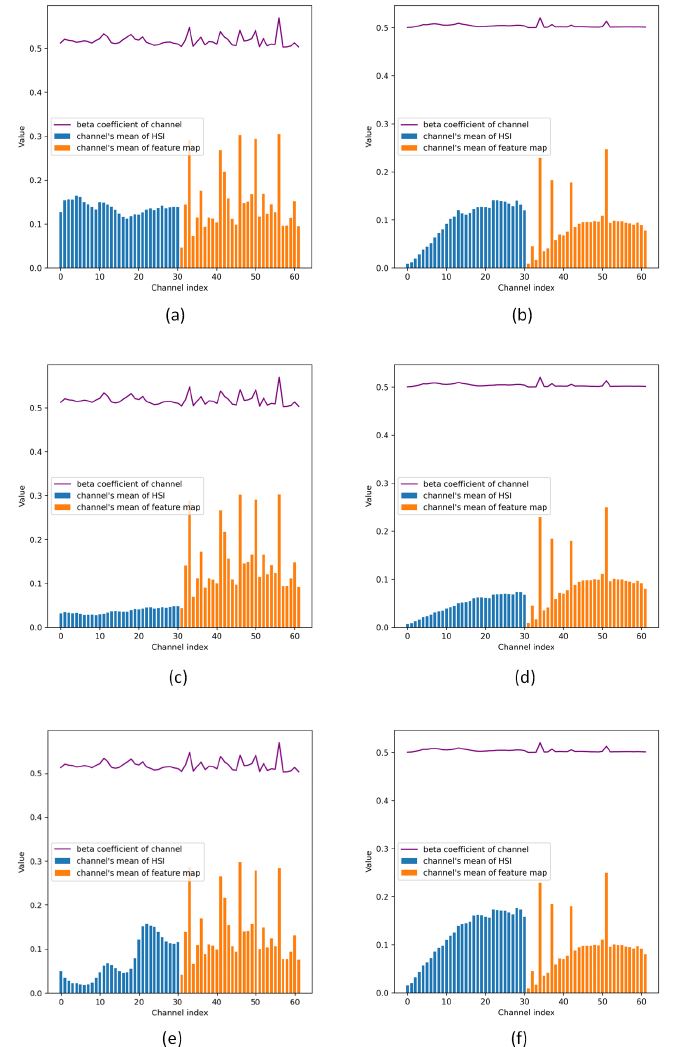
Figure 5. Mean and corresponding beta value of hyperspectral image and feature map. ( a , c , e ) represent the data of the three groups of images in the CAVE dataset; ( b , d , f ) represent the data of the three groups of images in the HARVARD